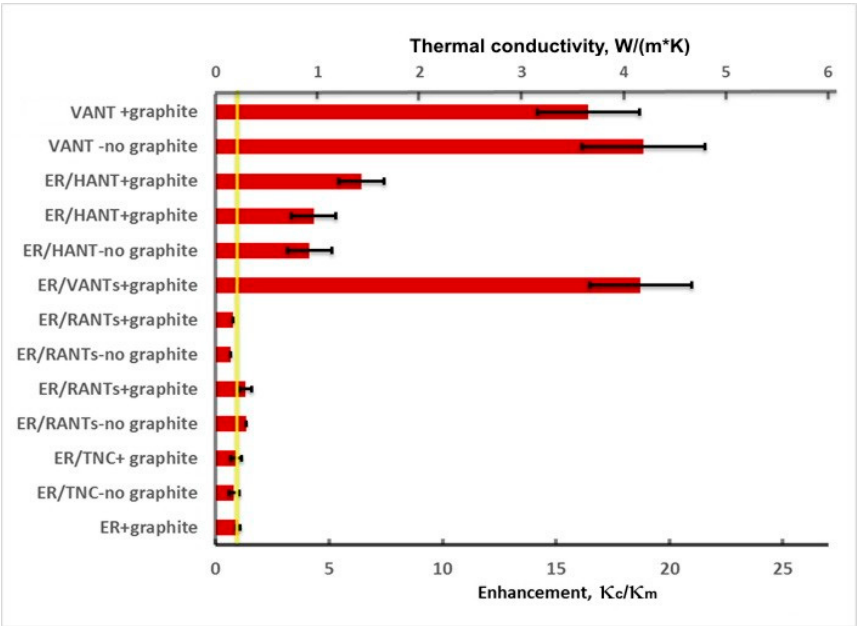
Figure 4. Thermal conductivity and enhancement for some ER-based composites filled with different types of CNTs.